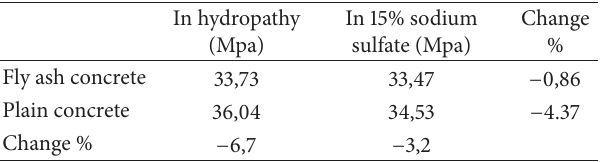
Figure 3: Generation of cavities on surfaces of the plain concrete specimen due to sulfate reactions. Table 6: Compressive strength values of 28-day-old cubic samples (Mpa).